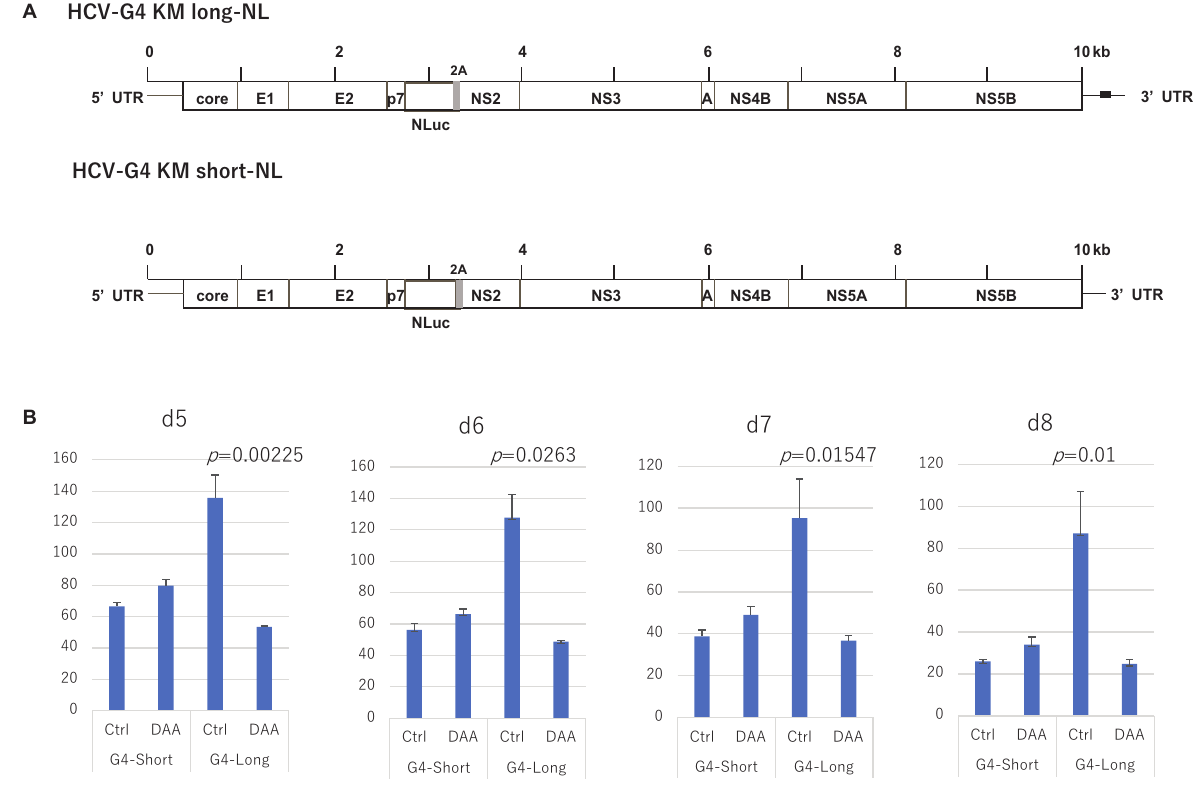
FIGURE 5 | Construction of NL-containing HCV-G4 expression vectors, HCV-G4 KM long-NL and HCV-G4 KM short-NL (A) . Poly (U) stretch in 3 (cid:48) UTR of HCV-G4 KM long is indicated as a black box. (B) These clones were used to infect Huh-7.5 cells expressing SEC14L2 and measured after day 5, 6, 7 and 8 ( n = 4). Their replication activity was measured by NL assays. Treatment with DAA (30 µ M sofosbuvir) decreased their replication. Significant differences based on the control were evaluated by statistical analysis ( t -test, 2-sided), and a p -value less than 0.05 was considered significant.